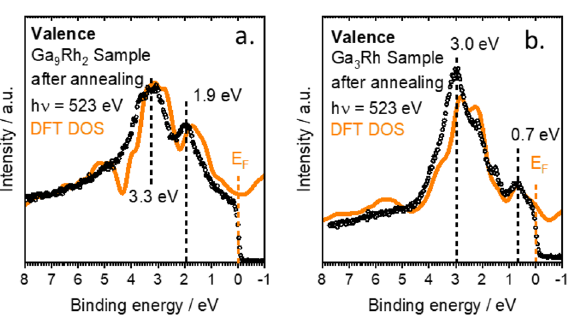
Figure 5. Combined valence band measurements (black dots) and calculated density of states (orange lines) for ( a ) Ga 9 Rh 2 and for ( b ) Ga 3